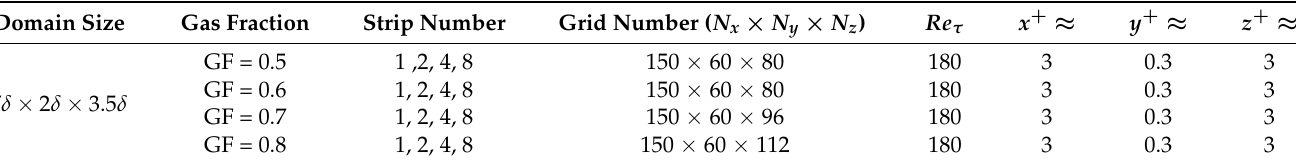
Table 1. Simulation parameters. Gas fraction is the area ratio of free-slip to no-slip surface. Strip number represent the number of strips in a spanwise period. Re τ is friction Reynolds number. Grid number is the number of point for streamwise, wall-normal, and spanwise